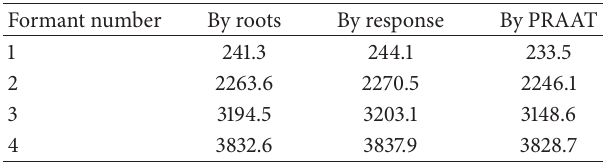
Table 1: Comparison of computed formant frequencies for male vowel